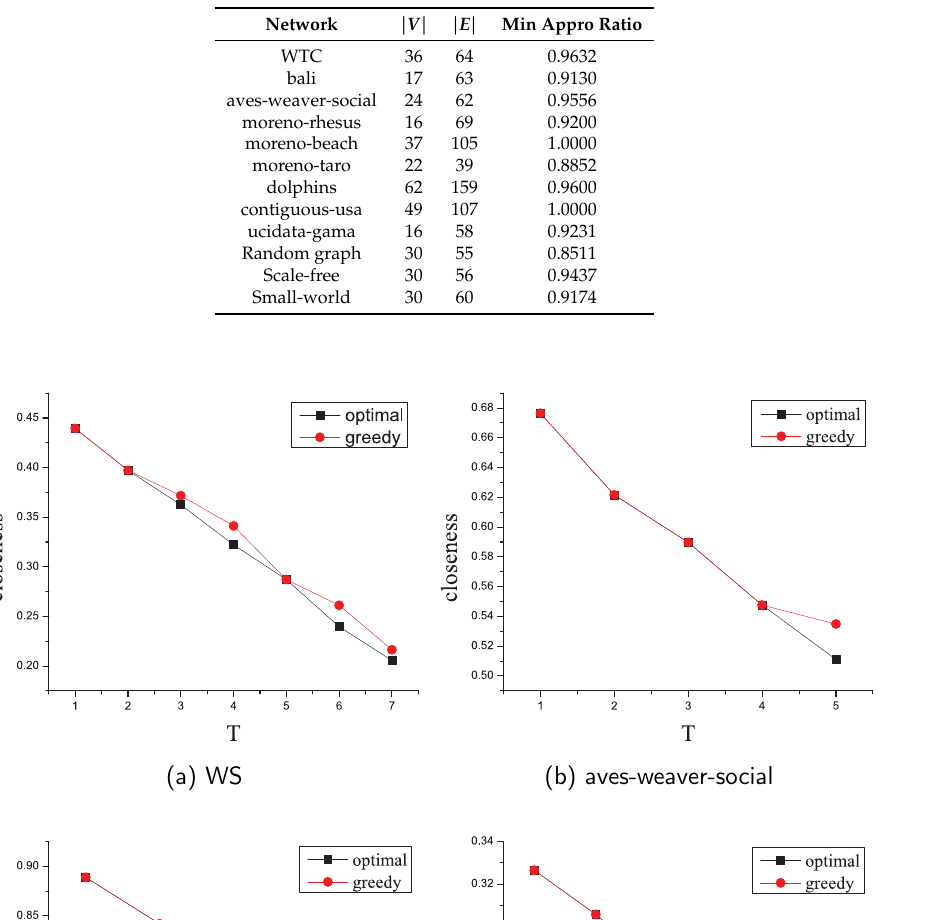
Table 5. Datasets used in comparing greedy solutions with the optimal solutions.